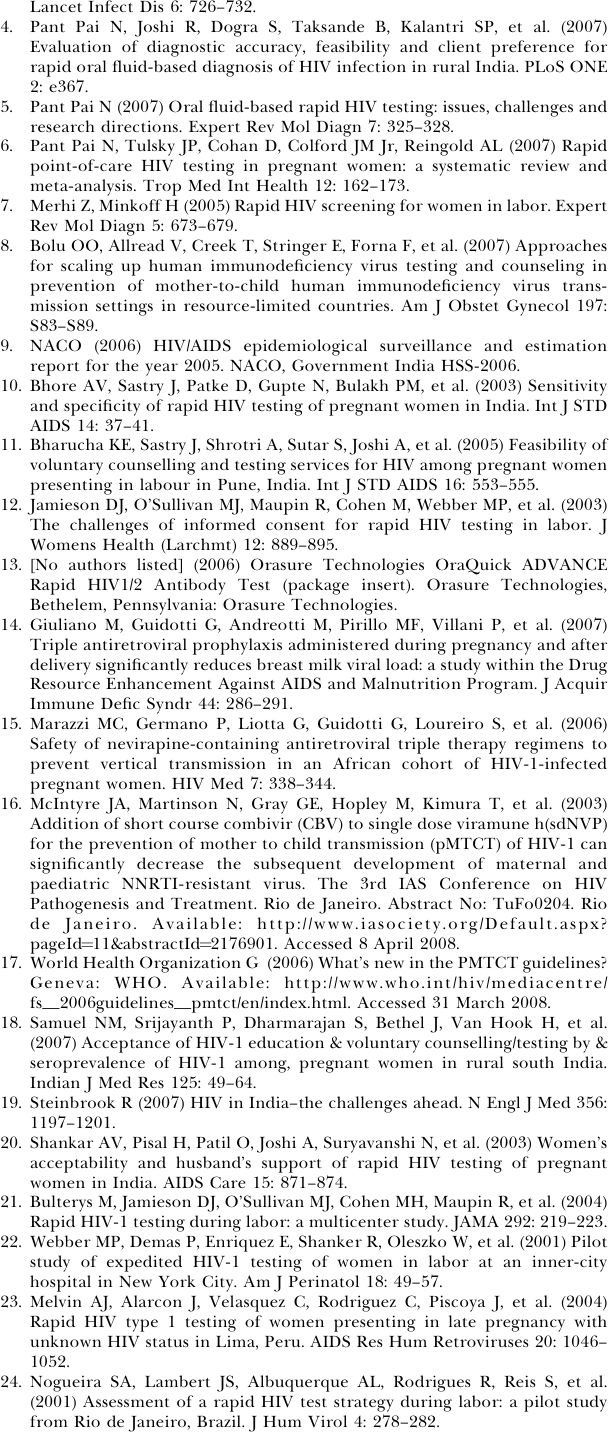
Figure S1. HIV Testing Algorithm Found at doi:10.1371/journal.pmed.0050092.sg001 (33 KB